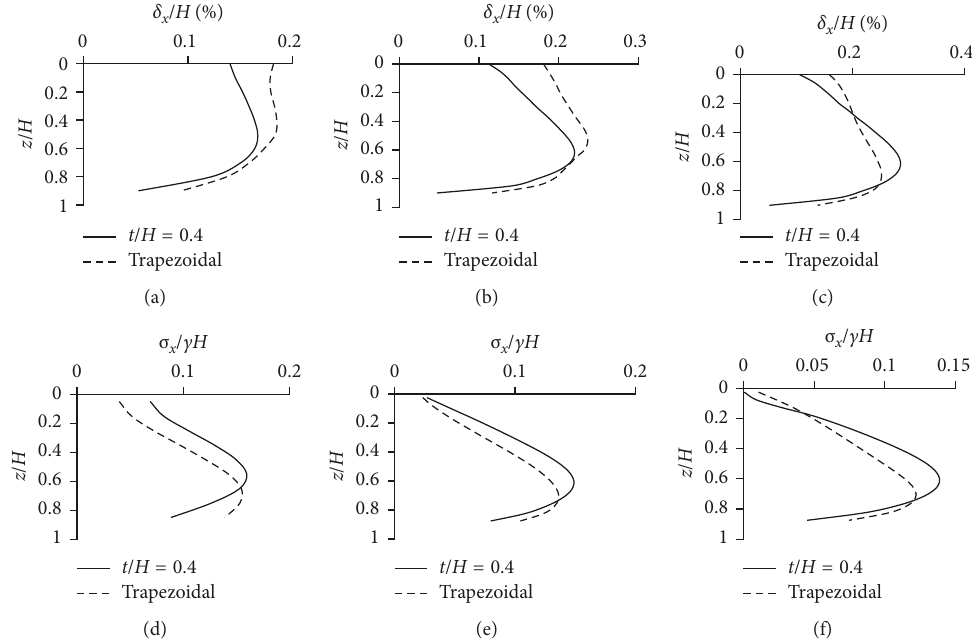
Figure 9: Effect of trapezoidal geofoam panel and one rectangular geofoam panel with the relative thickness of 0.4 H on (a, b, and c) lateral displacements of soil and (d, e, and f) distribution of forces on yielding retaining walls. (a) H (e) H 6m. (f) H 9 (cid:31) (cid:31)